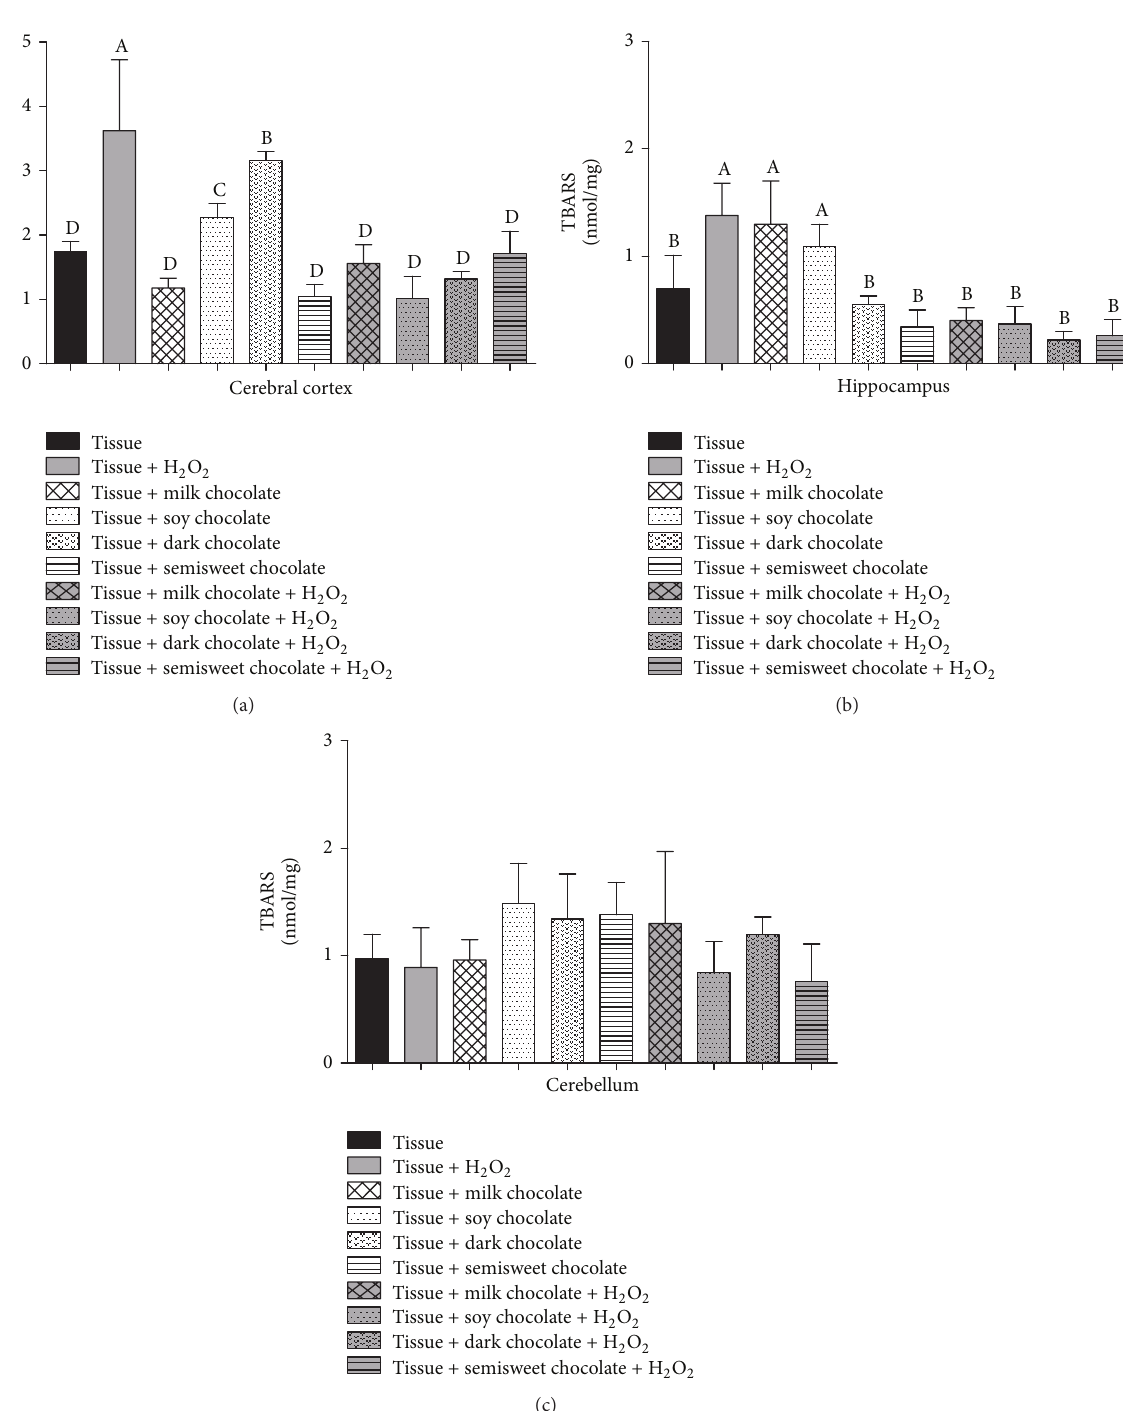
Figure 1: Levels of lipid peroxidation (TBARS) in cerebral cortex (a), hippocampus (b), and cerebellum (c) of Wistar ratstreated with different chocolate types with or without hydrogen peroxide. Different letters show statistical difference between them ( 𝑝 < 0.05 ).